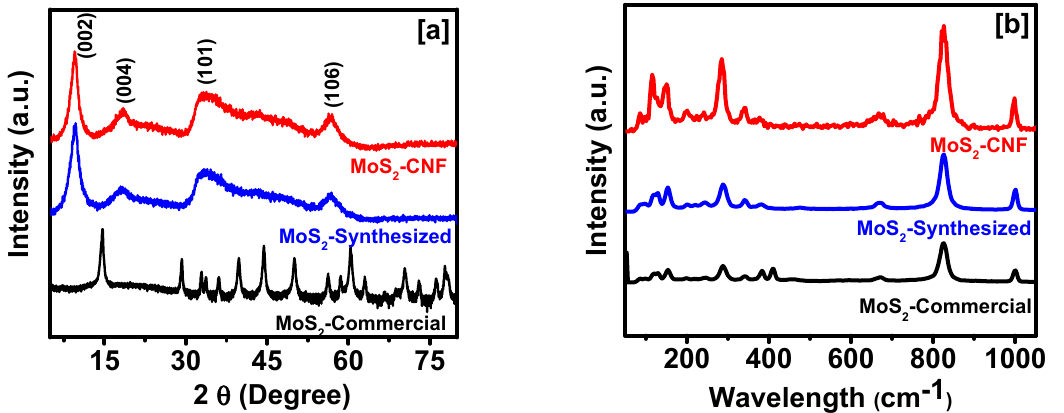
Figure 1. ( a ) X-ray diffraction (XRD) patterns (log scale is for MoS 2 -commercial); and ( b ) Raman spectra of various MoS 2 samples.